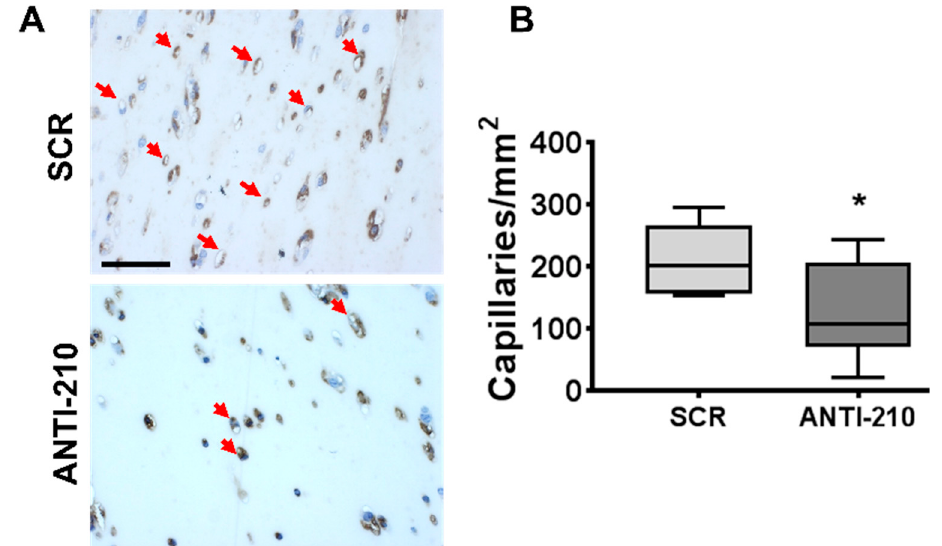
Figure 5. MiR-210 blocking decreases angiogenesis in Matrigel plugs in vivo. ( A ) Representative lectin staining of capillaries in Matrigel plugs sections 7 days post-implant. Magnification is shown at 400×; the calibration bar is at 50 µm. Red arrows indicate capillaries. ( B ) The box plot of capillary density quantification ( n = 9–10, test t , * p = 0.03).